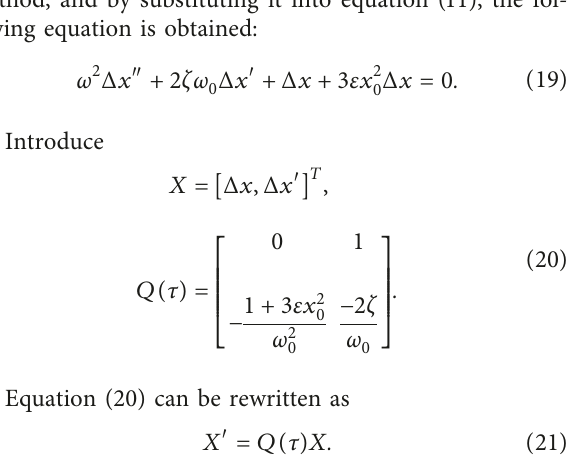
Figure 8: Amplitude-frequency